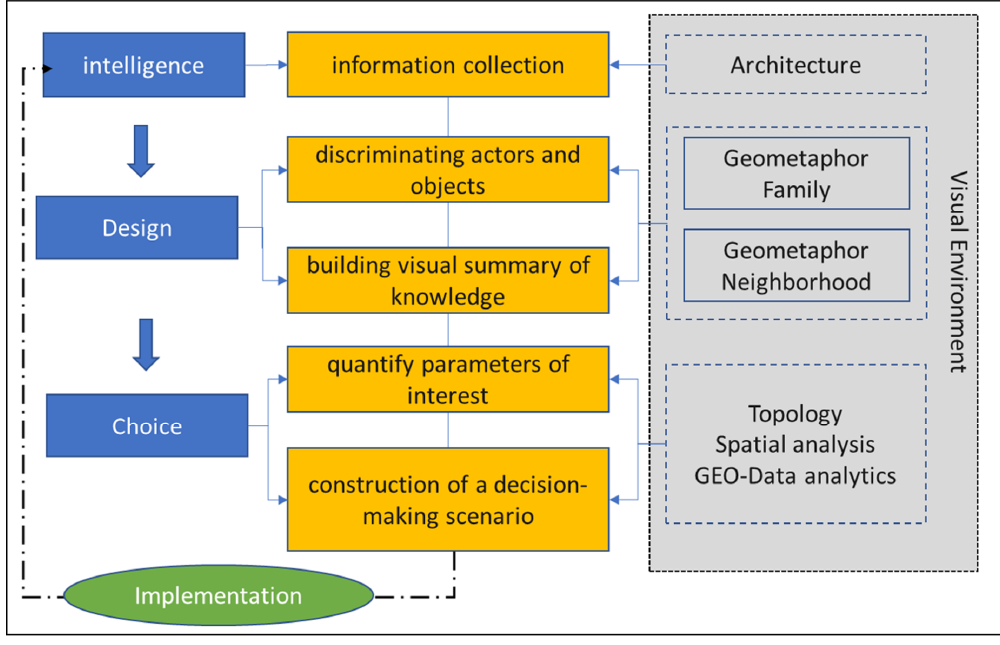
Figure 2. The three macro-phases underlying the SAFE model.